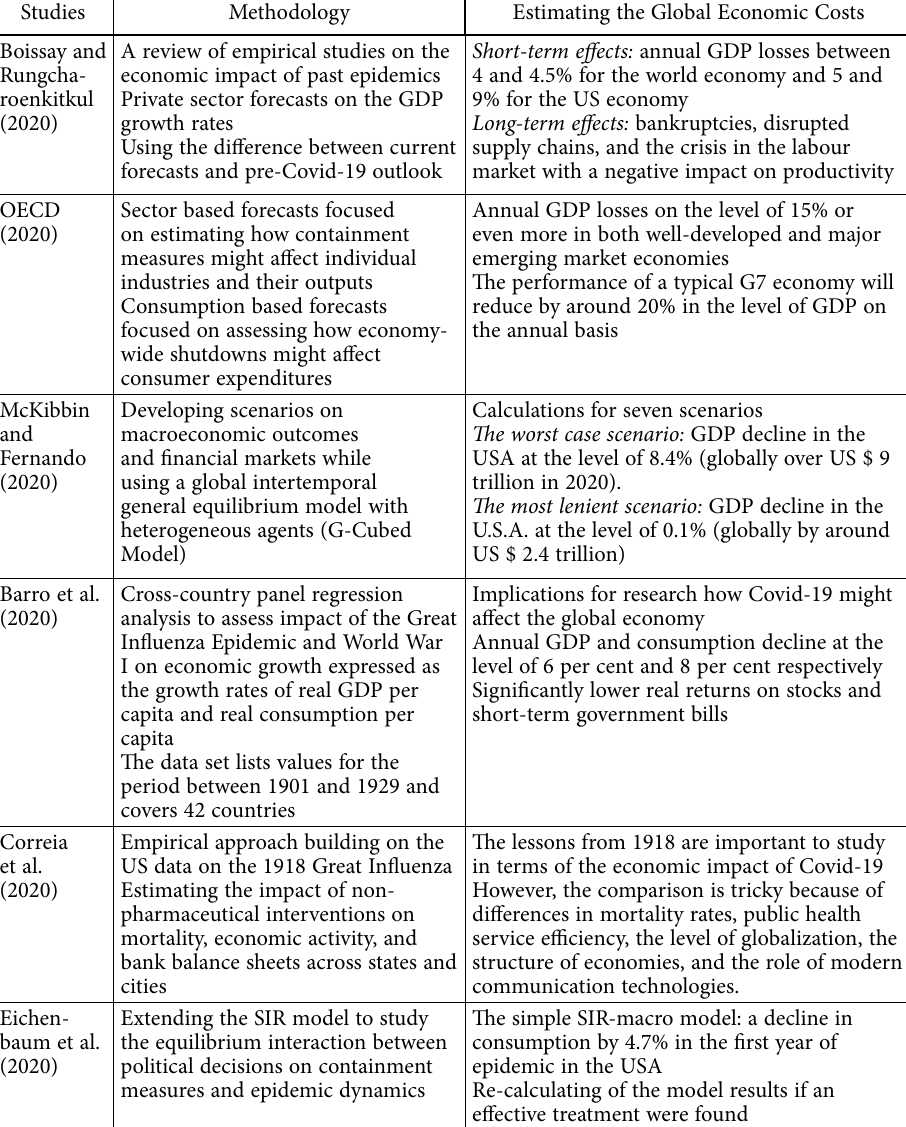
Table 1. Research on impact of Covid-19 on economic activity (source: elaborated by the authors) Studies